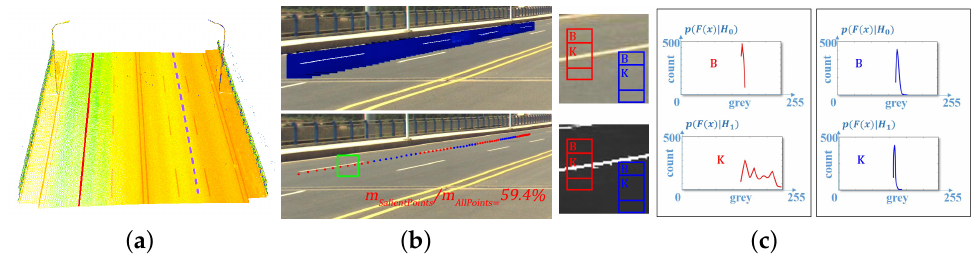
Figure 26. Textural saliency analysis of the dashed lane markings near the road boundary. ( a ) The dotted purple line is the trajectory, and the red line is the inferred lane line. ( b ) The lower picture shows the inferred line that is sampled and mapped onto the image. Through textural saliency analysis, valid sampling points are marked in red and invalid ones are marked in blue. The upper picture presents the saliency values of the buffers around each sampling point. The green box is a buffer of a valid sampling point. ( c ) Two detector windows and their saliency values are shown on the left. The contrast of the K and B windows, whose distributions of the gray values are shown on the right, decides the saliency values.